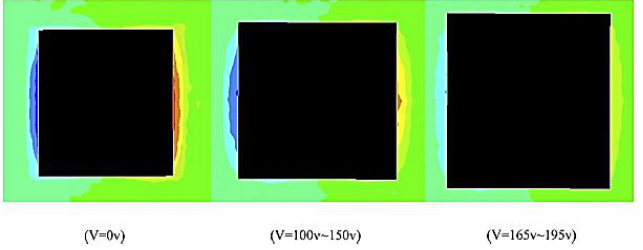
Figure 9. FEM simulation of shear stress distributions along delamination edges with different voltages (L1 = L2 = 0.1 m, a = b = 0.1 m, t = 0.005 m)